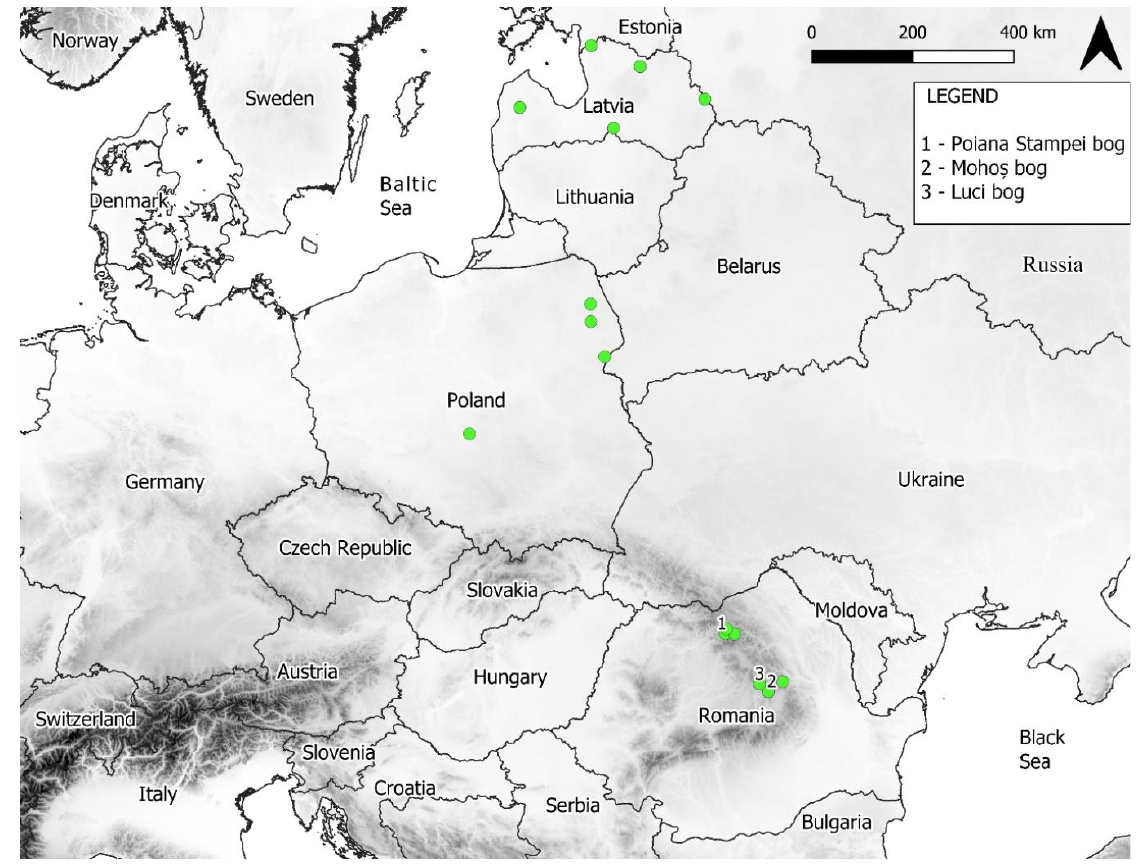
Figure 1. Approximate geographical distribution of the pine, bog woodland communities considered in the present study (green